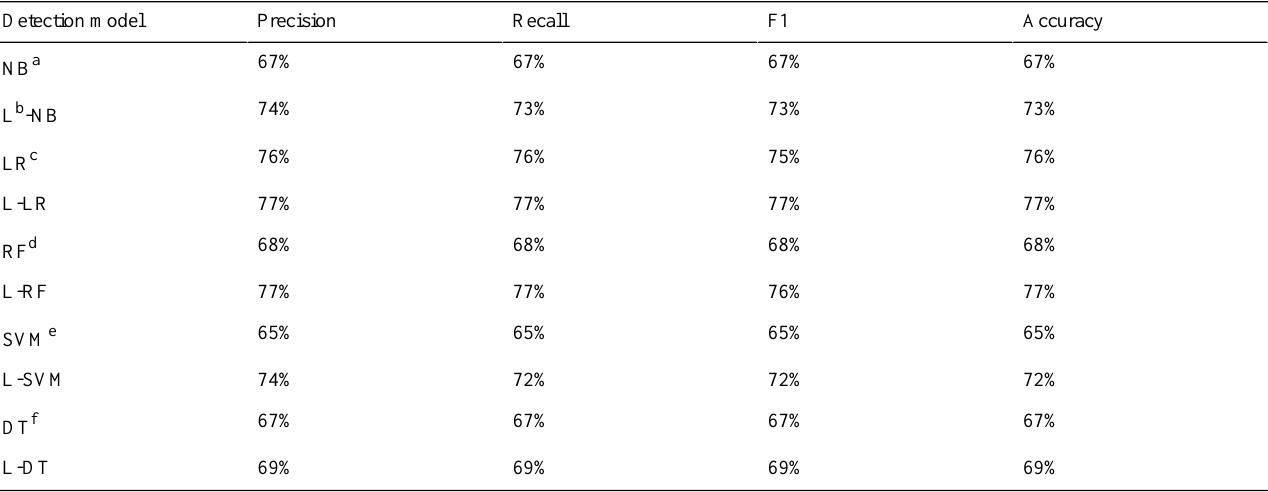
Table 7. Detection model performance with the depression-domain lexicon.